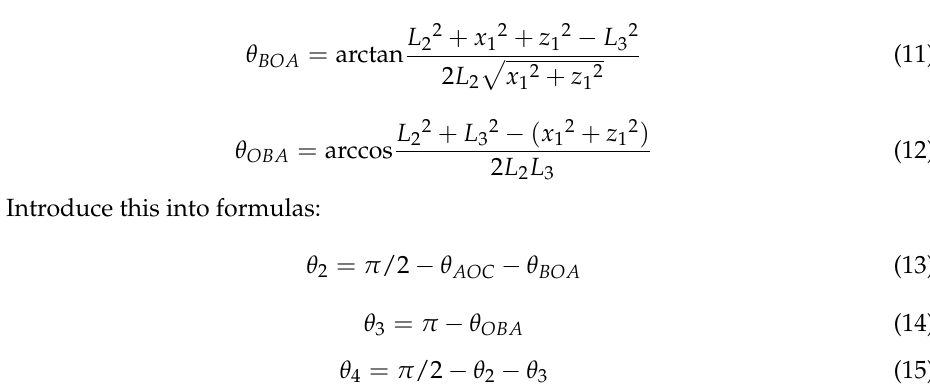
Figure 13. Coordinate system plane. ( a )XOY plane ( b )XOZ plane.